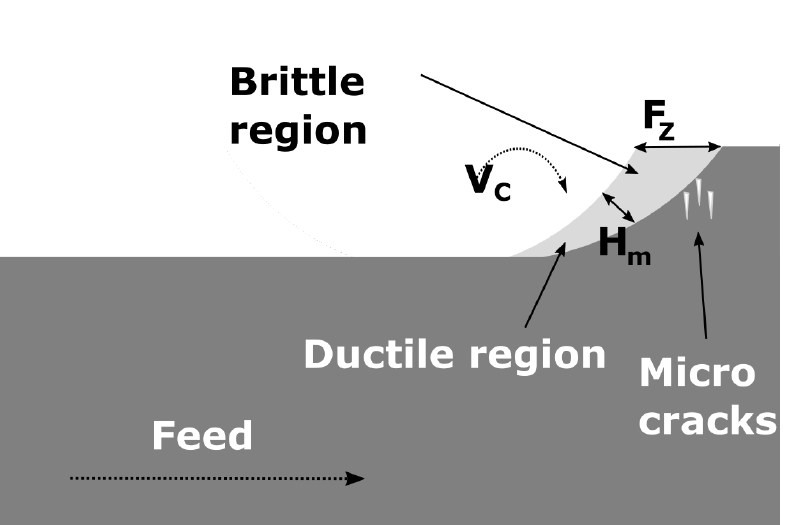
Figure 20. The kinematics showing the brittle to ductile transition during chip formation. Following this, the next tooth of the cutter enters the material, repeating the process. The induced micro-cracks were removed in the brittle cutting regime, before the ductile regime sets in again. This is supported by the lower amount of sub-surface damage in ductile mode (see Section